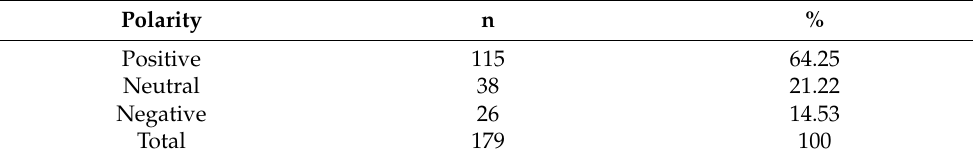
Table 7. Frequency and percentage of responses with positive, negative, and neutral polarities.